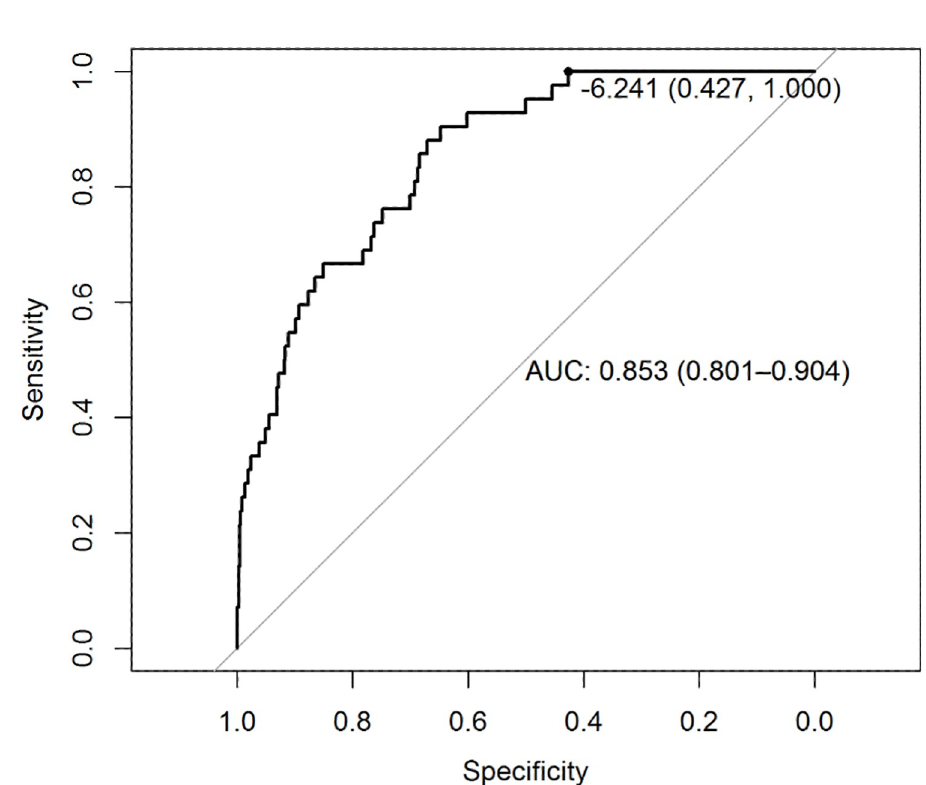
Fig 2. ROC curve of the CoLab-linear predictor. The area under the ROC curve is shown with the 95% DeLong confidence interval in round brackets. The displayed threshold of -6.241 corresponds to a sensitivity of 100%, i.e. no HCWs below this linear predictor were RT-PCR